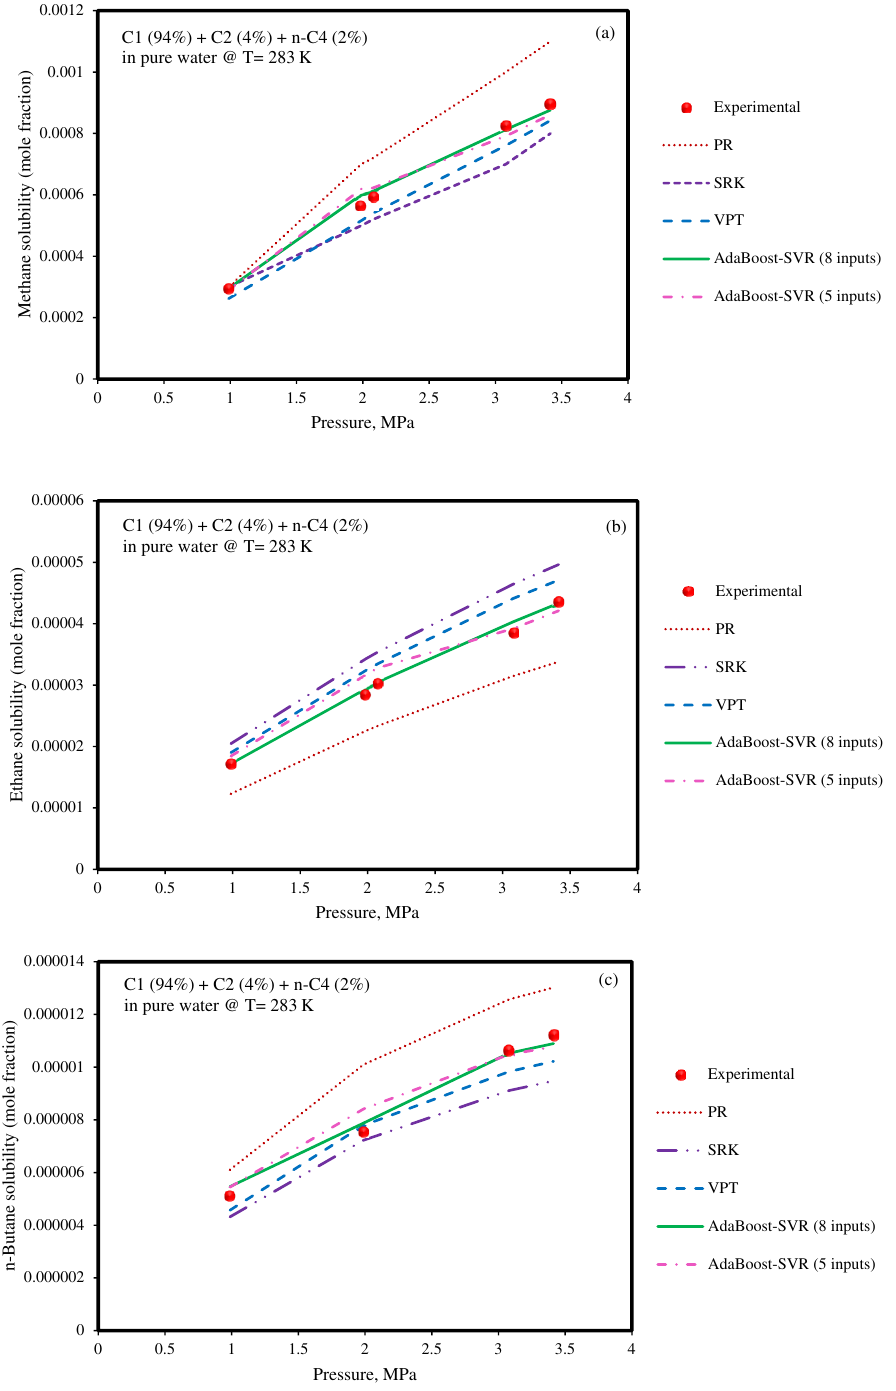
Figure 7. Experimental values and estimations of the solubilities of ( a ) methane, ( b ) ethane, and ( c ) n -butane in the aqueous phase of the gas mixture + water system by EOSs and AdaBoost-SVR